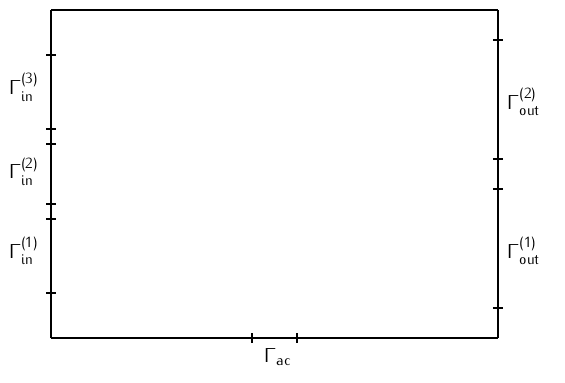
i ) , 1 ≤ i ≤ 3 , two outflow boundaries Γ ( i ) Γ ( in